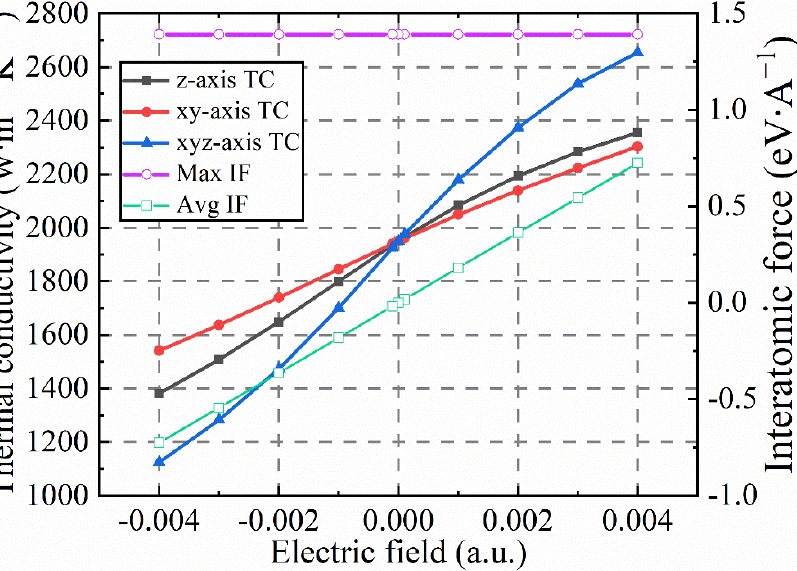
Figure 14. The relationship between lattice thermal conductivity, maximum force between atoms, average force and electric field intensity after applying an electric field in three crystallographic directions of diamond (T = 300 K).